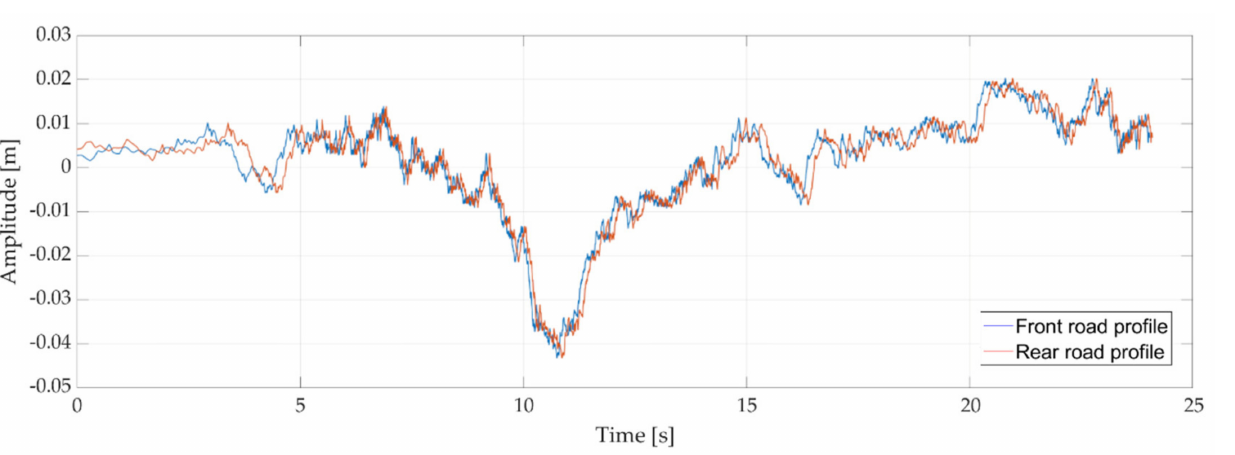
Figure 20. Example of the delay between the front and rear wheels of the